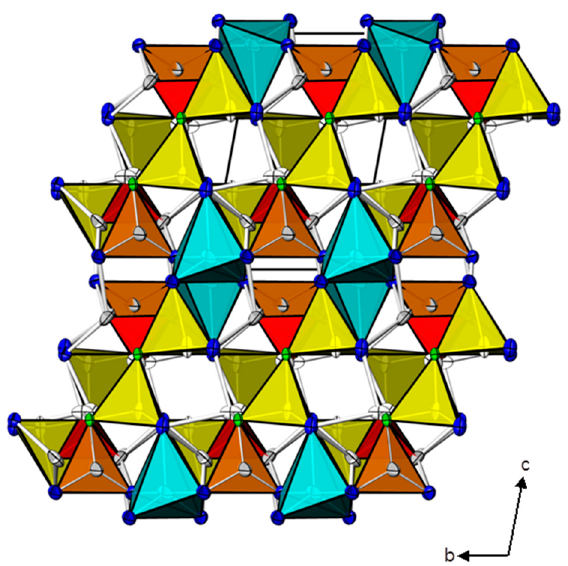
Figure 8. Crystal structure of Zn(Hg II ) 4 O 4 (CrO 4 ) using oxygen-centred tetrahedra for visualisation. [OHg 2 Cd 2 ] and [OHg 3 Cd] tetrahedra are yellow, [OHg 2 Cd] trigonal pyramids are orange and [OHg 5 ] trigonal bipyramids are turquoise. Displacement ellipsoids are as in Figure 3.